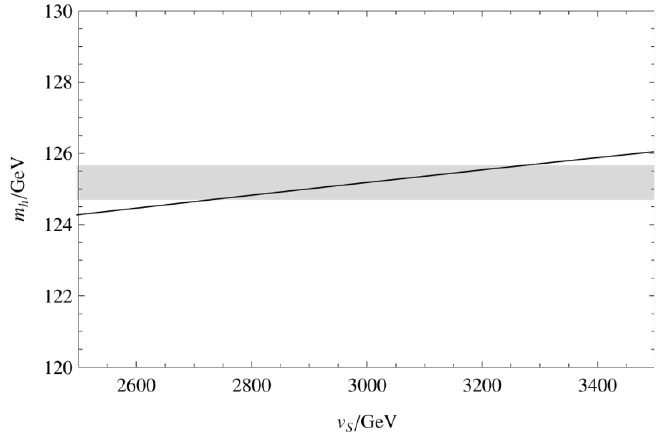
Figure 1 . Considering the loop corrections, the lightest CP-even Higgs mass ( m h ) versus v S is plotted by the solid line with A t =2.6